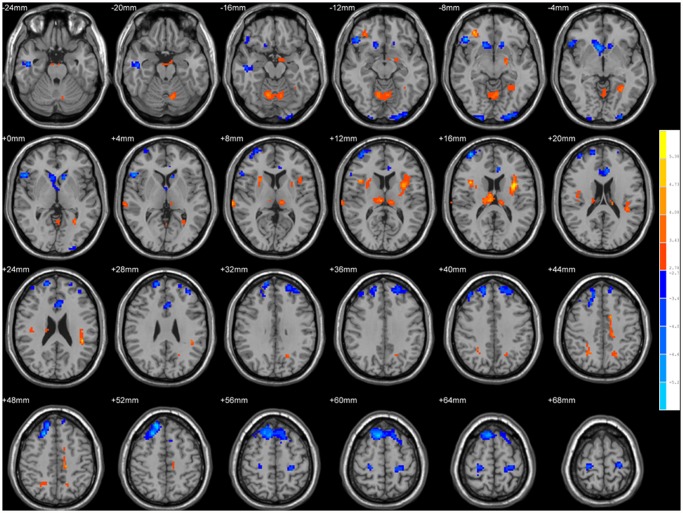
Brain areas with altered ReHo compared with healthy controls (Alphasim corrected, p
alpha<0.05).The blue areas showed decreased ReHo in acute SCI patients relative to healthy controls. The regions are the bilateral primary motor cortex/primary somatosensory cortex, bilateral supplementary motor area/ dorsal lateral prefrontal cortex, right inferior frontal gyrus, bilateral dorsal anterior cingulate cortex and bilateral caudate. The red areas showed increased ReHo in acute SCI patients. The regions include bilateral precuneus, the left inferior parietal lobe, the left brainstem/hippocampus, the left cingulate motor area, bilateral insula, bilateral thalamus and bilateral cerebellum. The left side of the image corresponds to the right hemisphere of the brain. The underlying structure image is Ch2 image.